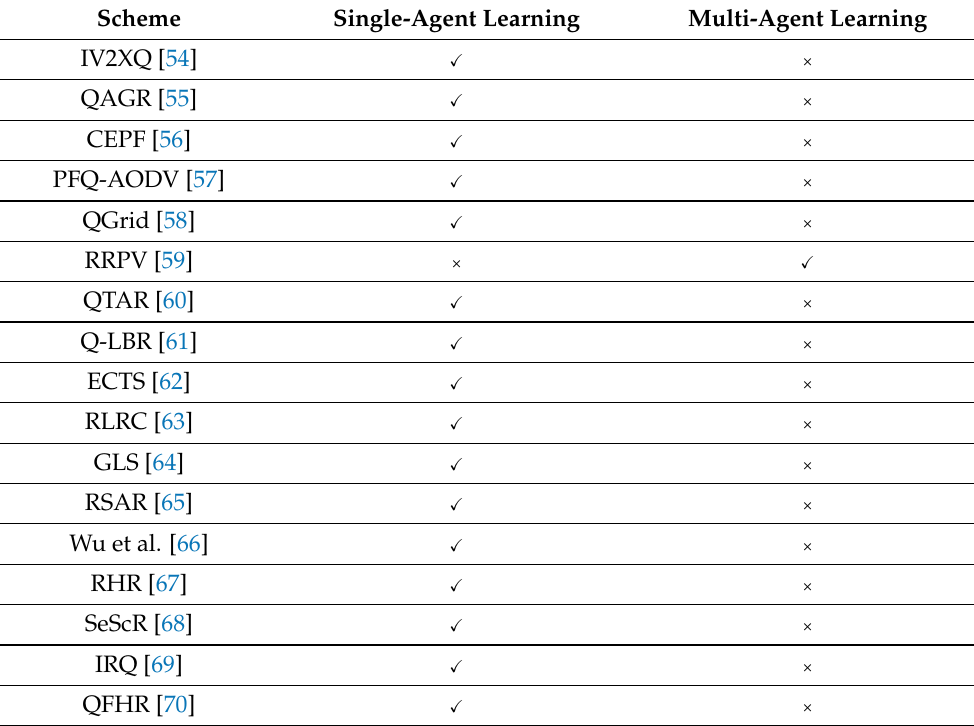
Table 12. Comparison of RL-based routing methods in terms of learning framework.